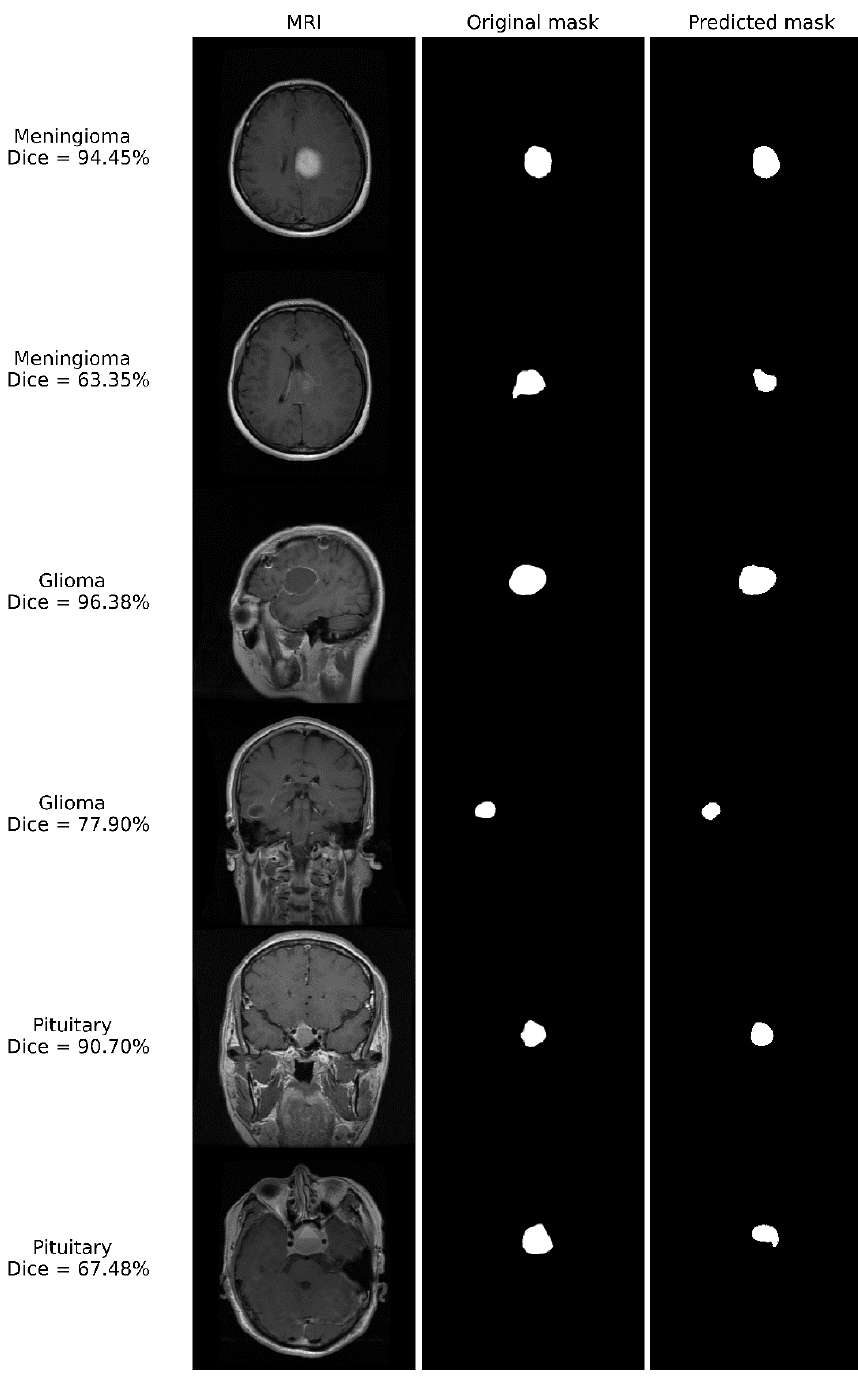
Figure 3. Examples of segmentation after training the network on the original dataset with record- wise data division. The original MRI image, mask, and segmented tumor are shown. The type of tumor, as well as the Dice coefficient achieved, are also indicated.